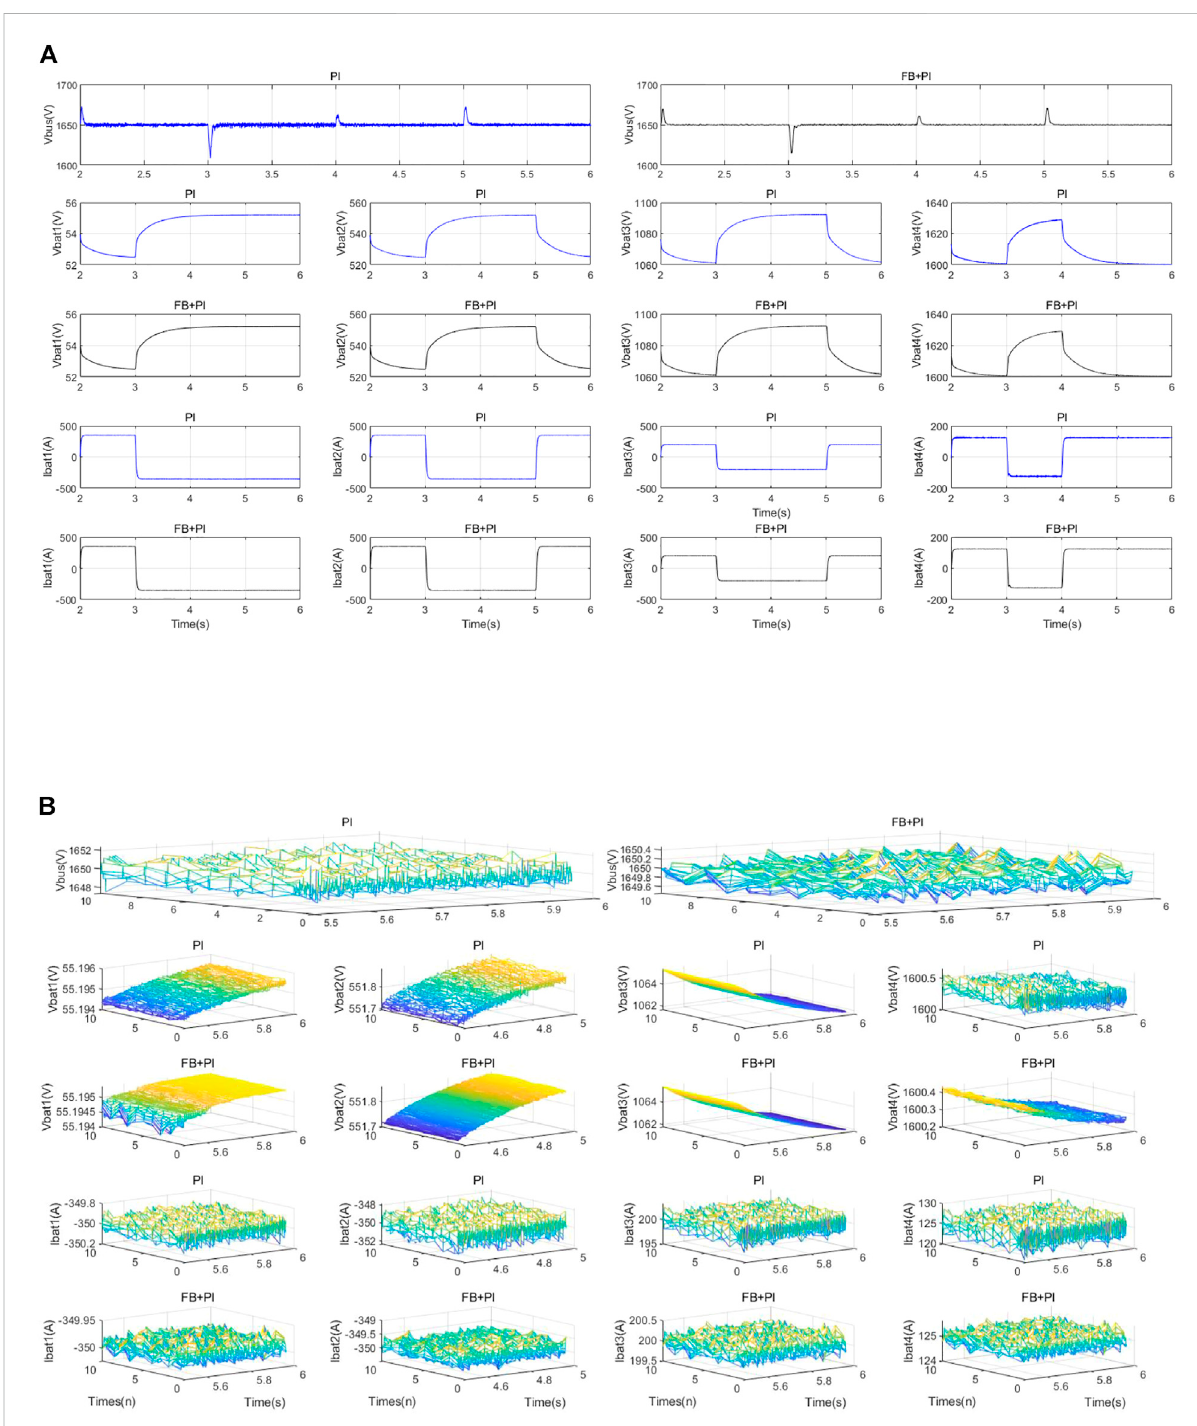
FIGURE 11 (A, B) shows the transient response under grid imbalance in the traditional double closed-loop control strategy in Figures 14 and under grid normal in the control strategy proposed in this paper in Figures 16,